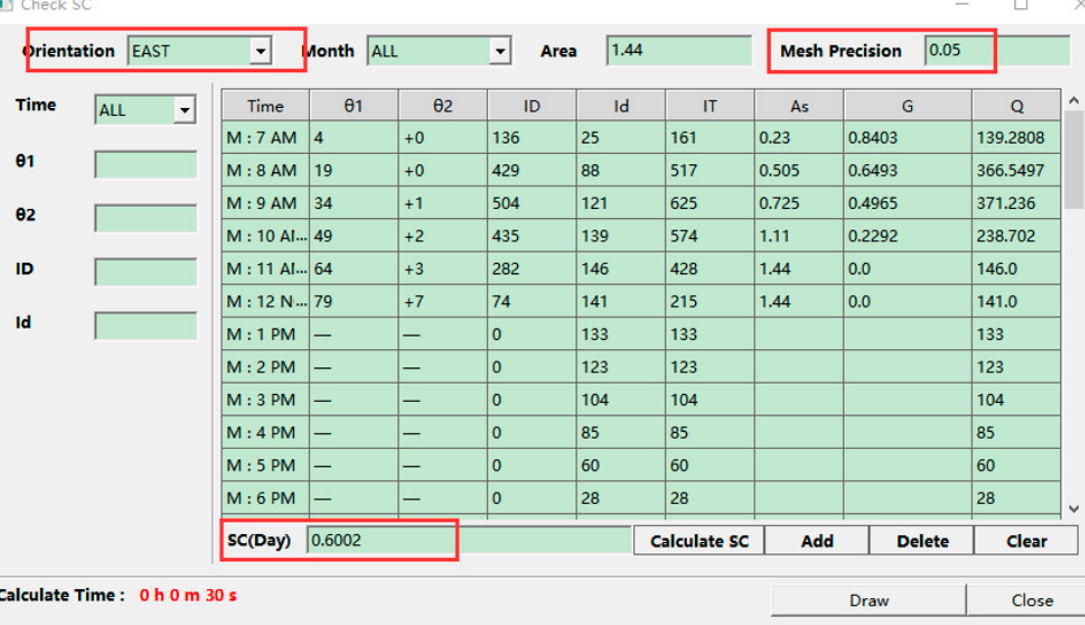
Figure 20. SC2 calculation by using the proposed digital method.